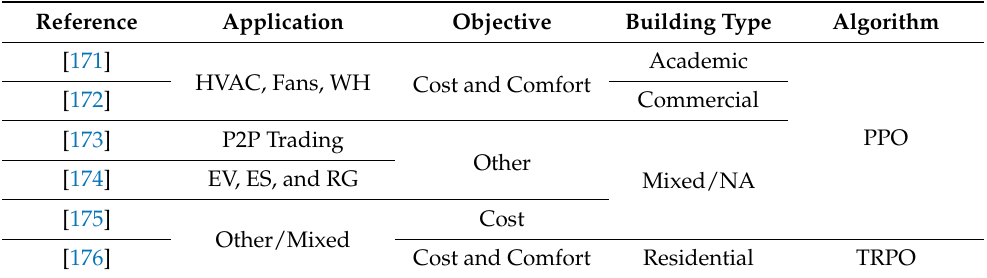
Table 3. References using Deep Policy